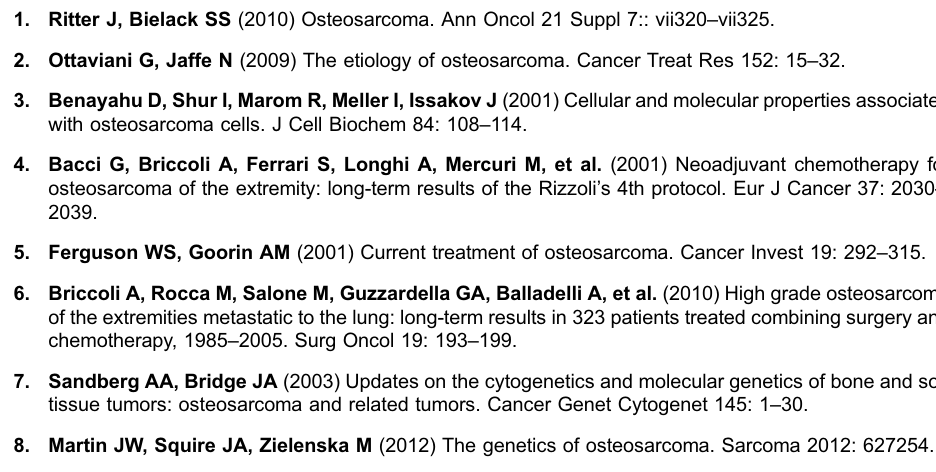
S1 Fig. Genes in focal losses with underexpression (FC , 0.75, A) and in focal gains with overexpression (FC . 1.5, B) in more than 35% of osteosarcomas in the validation dataset. Green: expression fold change (FC) , 0.75 of the gene in the tumor relative to osteoblasts (underexpression). Red: expression fold change (FC) . 1.50 of the gene in the tumor relative to osteoblasts (overexpression). For each gene, the number (n) and fraction (%) of osteosarcomas with the indicated fold change (FC) are given. S1 Table. Expression fold change for all genes in focal losses (upper panel) or focal gains (lower panel) in 31 osteosarcoma samples. Green: expression fold change (FC) , 0.75 of the gene in the tumor relative to osteoblasts (underexpression). Red: expression fold change (FC) . 1.50 of the gene in the tumor relative to osteoblasts (overexpression). For each gene, the number (n) and fraction (%) of osteosarcomas with the indicated fold change (FC) are